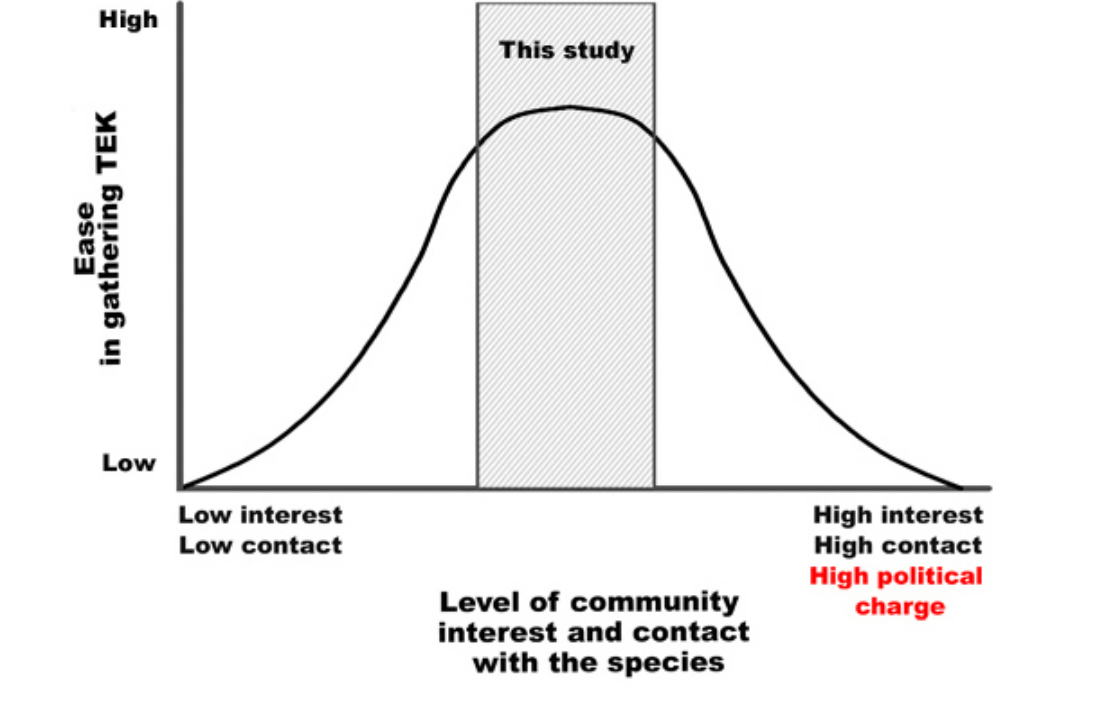
Fig. 2 . A conceptual graph showing how the level of the local community’s interest in and contact with a given species influences the ease with which it is possible to gather traditional ecological knowledge (TEK) about this species. When a community has little interest in or contact with a given species, e.g., some cryptic insects, TEK is low and therefore cannot be gathered productively (left side of the curve). Conversely, when the community is highly interested in a species, issues surrounding this species can be locally strongly politically charged, e.g., polar bears in some communities, and TEK can become difficult to acquire without bias (right side of the curve), although responses can be broad and diverse. The arctic fox and greater snow geese studied here provided an ideal context to collect TEK (gray area, center of the graph), because both species are visible and harvested but do not incite strong